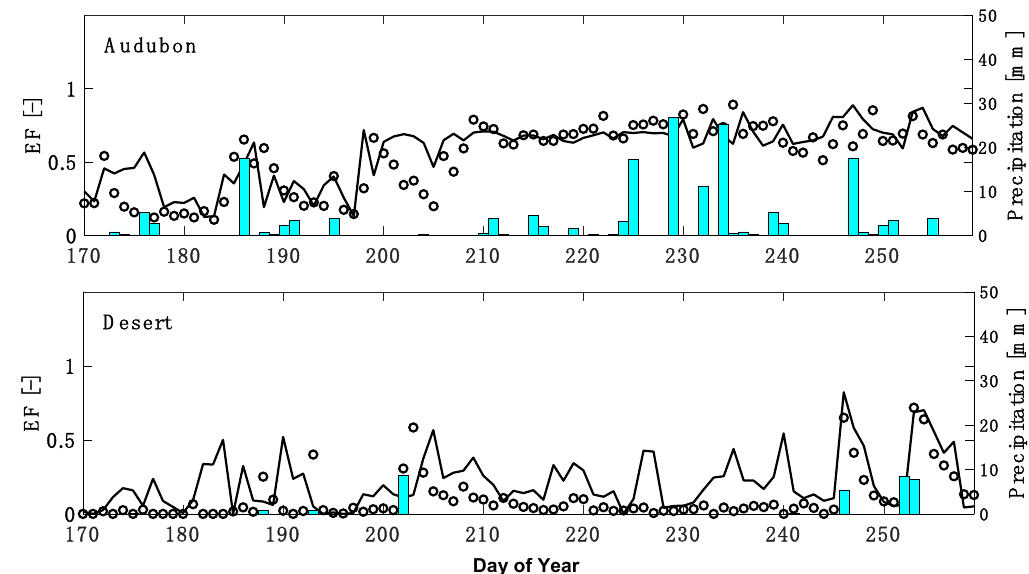
Figure 4. Time series of estimated (solid lines) and observed (open circles) EF values. Precipitations are shown by blue bars. Table 4. MAE and RMSE of EF estimates from the VDA approach at the six study sites. Mean soil